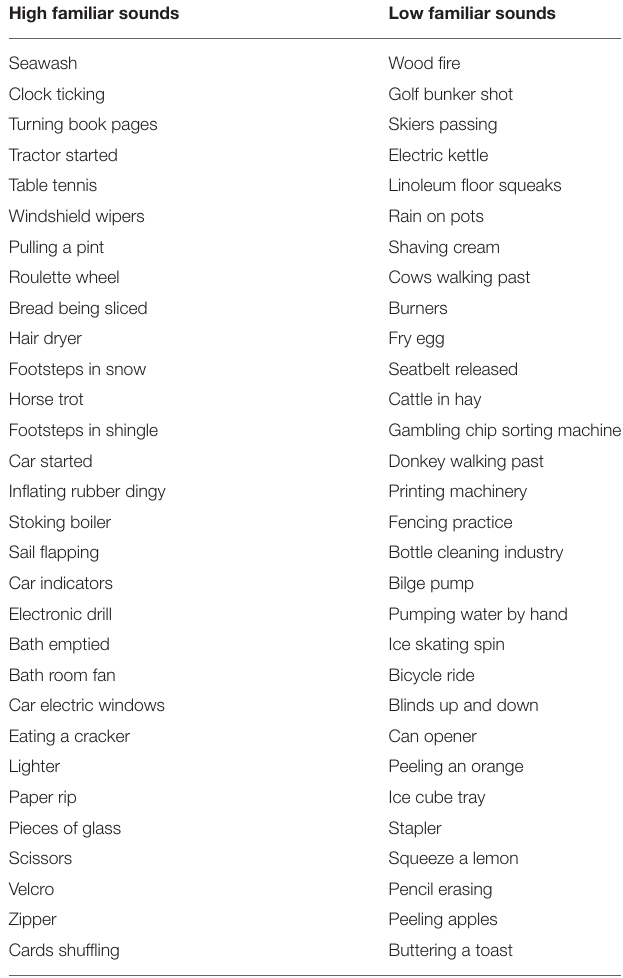
TABLE 3 | Sound sets of high and low